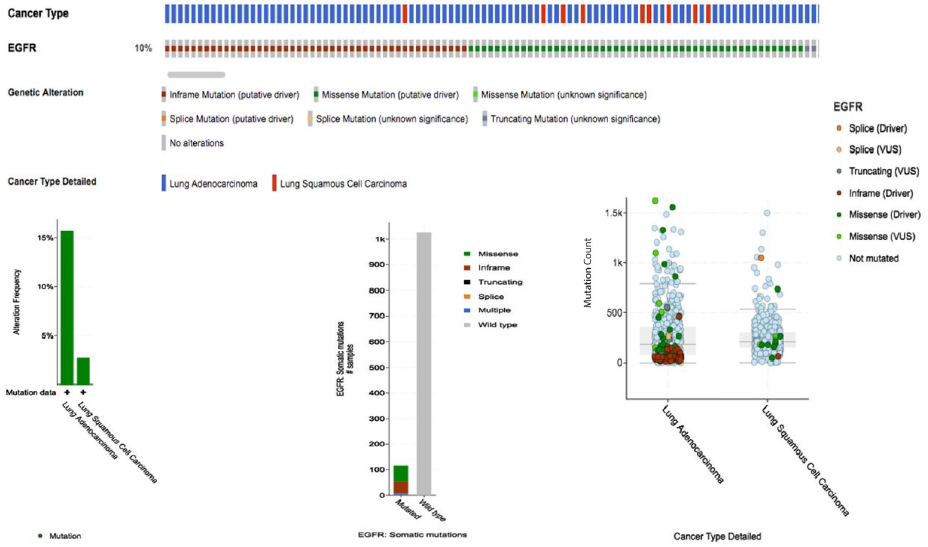
Figure 1. The EGFR gene in lung cancer from The Cancer Genome Atlas (TCGA) database. The Oncoprinter showed the distribution and type of EGFR gene mutations in lung cancer samples (https://www.cbioportal.org/). VUS: Variants of unknown signi fi cance.